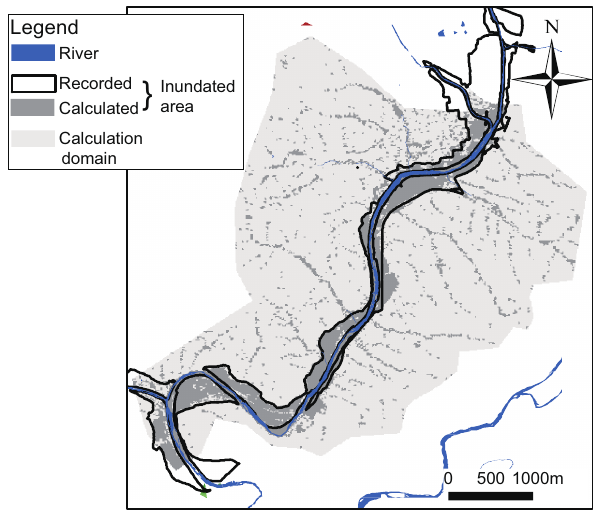
Figure 8. Comparison of calculated and recorded inundation areas (Tsubaki et al., 2012a).